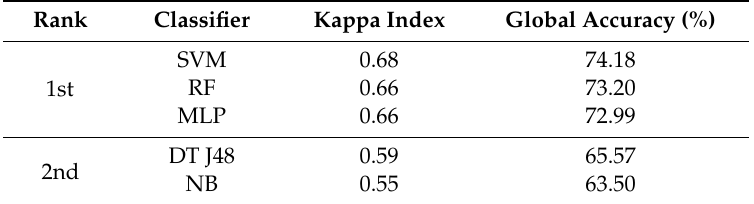
Table 3. Final ranking of the performance of the five classifiers employed. The legend has nine classes. Rank Classifier Kappa Index Global Accuracy